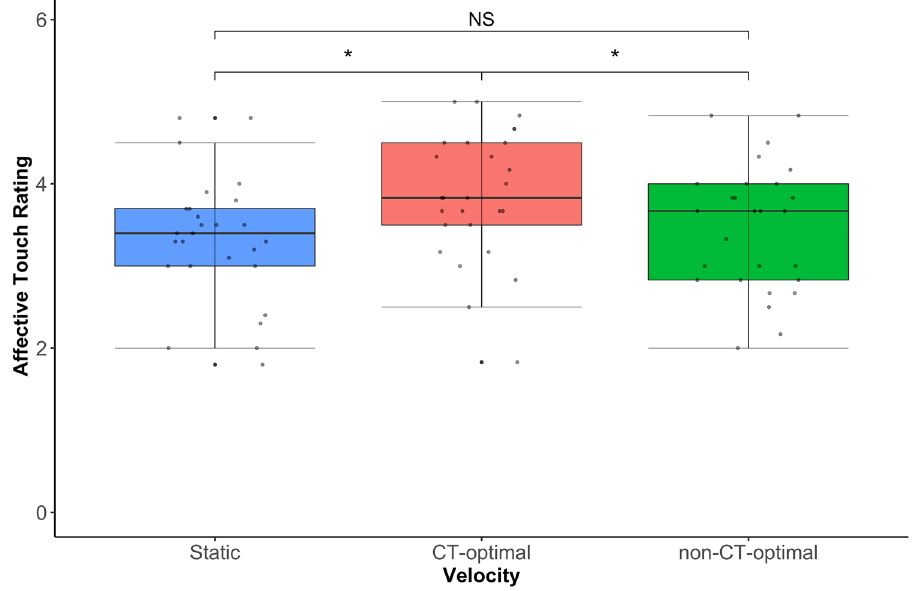
Figure 6. Mean affective touch ratings made by children over 3 velocities. There was a main effect of velocity and analysis of simple main effects confirmed ratings of slow CT-optimal (~ 3 cm/s) touch were significantly